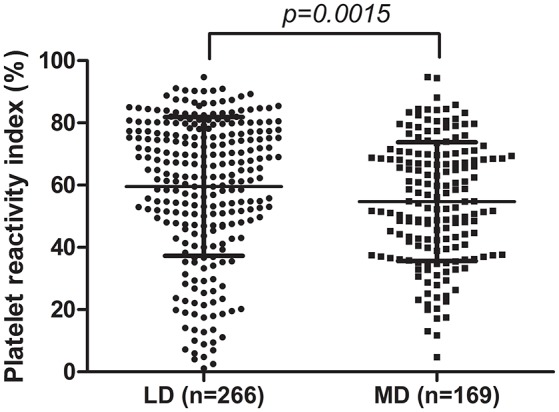
Comparison of PRI value between LD cohort and MD cohort.